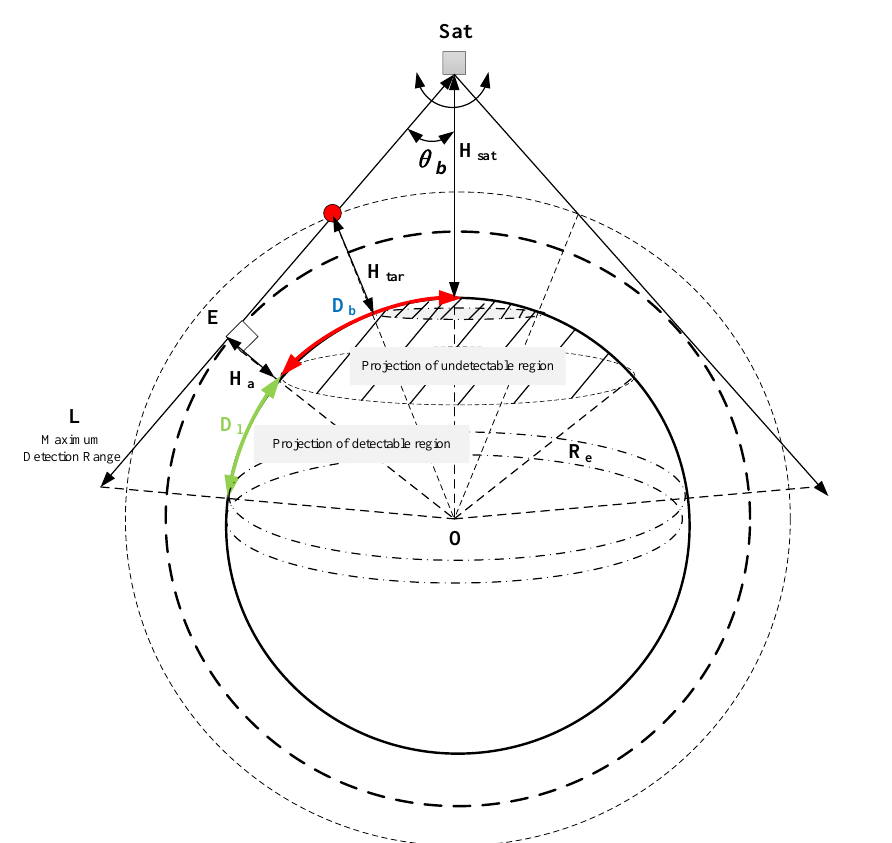
Figure 1. Observation model of the SODLC satellite.